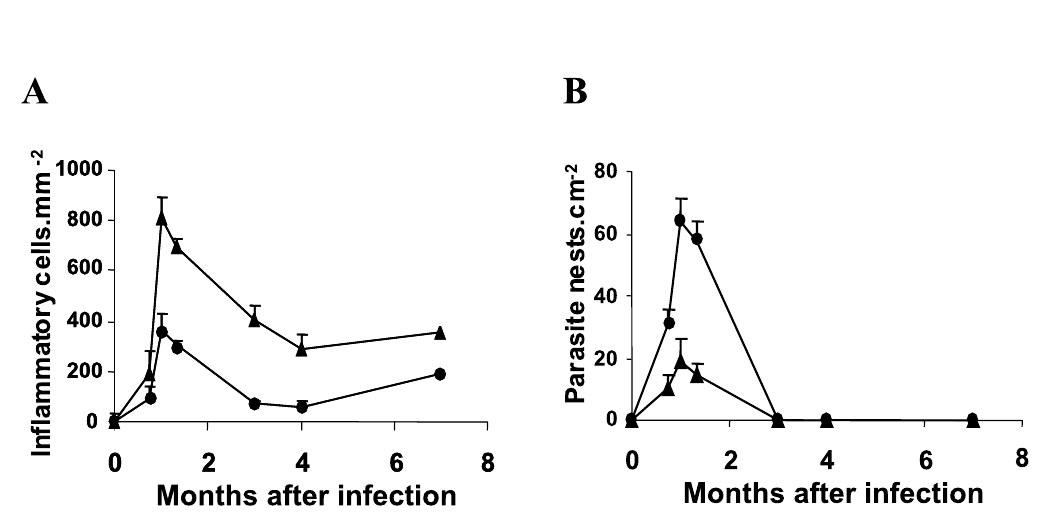
Fig. 2 – Myocarditis in IL-4–/– and wild-type BALB/c mice. Groups of IL-4–/– (triangles) or wild-type (circles) mice were infected with T. cruzi Colombian strain. A. number of inflammatory cells in the heart. B. number of parasite nests in the heart. Each symbol represents the mean value of 3 to 5 surviving mice. Vertical bars represent the standard deviations of the